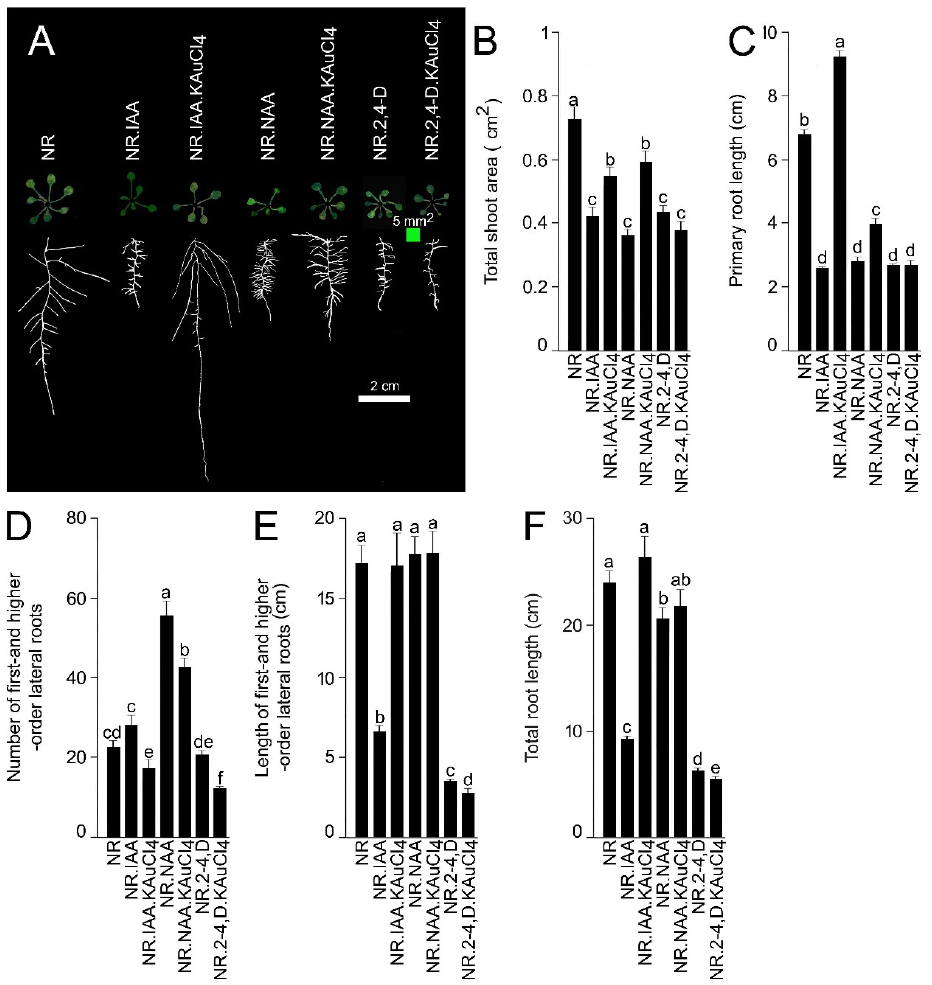
Figure 5. The differential recuperating effects of KAuCl 4 on the natural and synthetic auxin-mediated perturbation of the developmental responses of the root. Wild-type Arabidopsis seedlings were initially grown hydroponically in the NR medium for 7 d and then transferred to the NR medium supplemented with 0.1 µM each of natural (IAA) and synthetic (NAA and 2,4-D) auxins (NR.IAA, NR.NAA, and NR.2,4-D), and these media were supplemented with 10 ppm KAuCl 4 (NR.IAA.KAuCl 4 , NR.NAA.KAuCl 4 , and NR.2,4-D.KAuCl 4 ) for 7 d. ( A ) The seedlings were harvested, shoots and roots separated, and spread on an agar plate (1.0%; w / v) to document their phenotype. ( B – F ) Data are presented for ( B ) total shoot area, ( C ) primary root length, ( D ) the number of first- and higher-order lateral roots, ( E ) total length of first- and higher-order lateral roots, and ( F ) total root length. Values ( B – F ) are means ± SE ( n = 12) and different letters on the histograms indicate significant differences ( p <